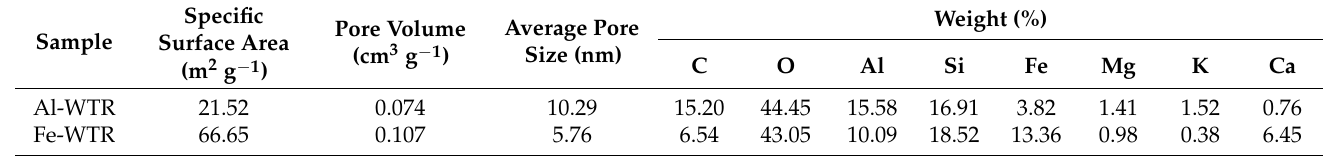
Table 1. Fe-WTR and Al-WTR basic physical and chemical properties.